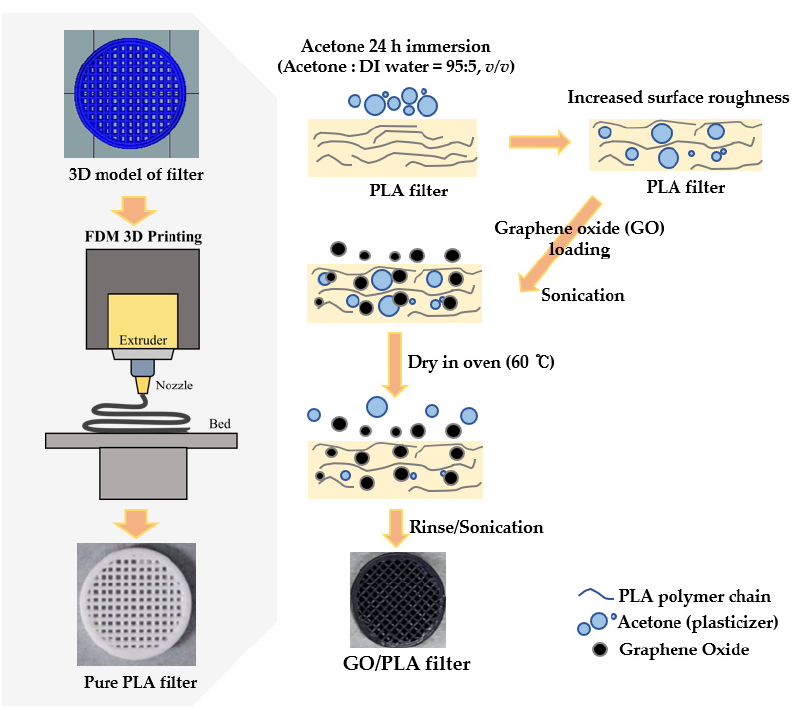
Figure 8. Schematic diagram of PLA fabrication with acetone pre-treatment to enhance GO dop- ing.